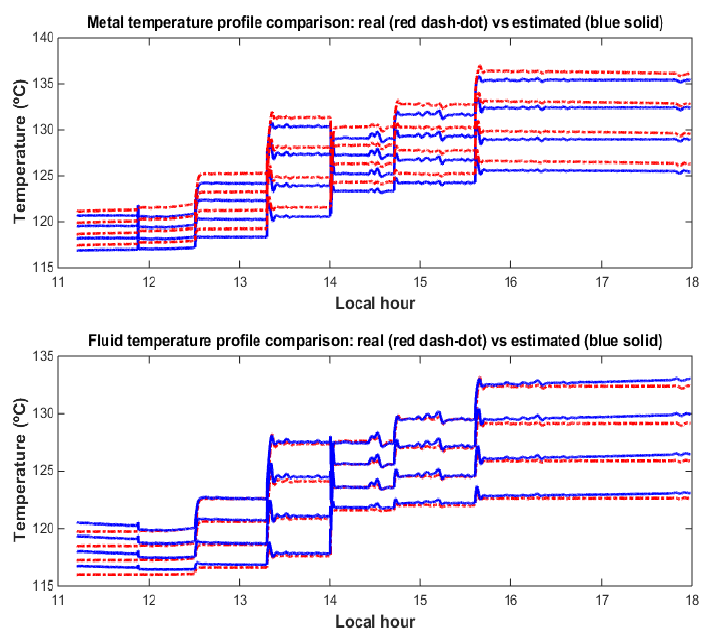
Figure 13. Simulation 1: Temperature profiles estimation. Estimated (solid blue line) and Distributed parameter model (dash red